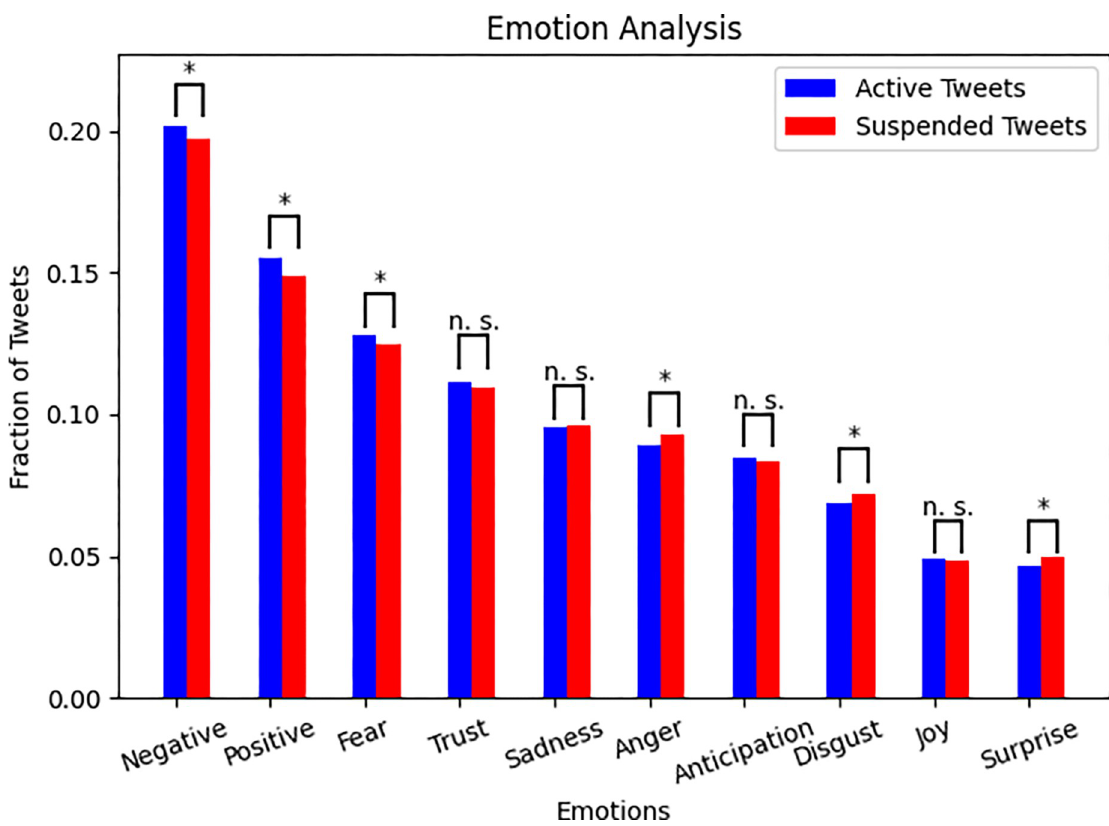
Fig 3. Distribution of predominant emotions and valence in tweets by active and suspended tweets. Note: � = Significant difference where P < 0.001 for Negative and Positive, P = 0.01 for Fear and Disgust, P = 0.004 for Anger, and P = 0.001 for Surprise. n. s. = Not